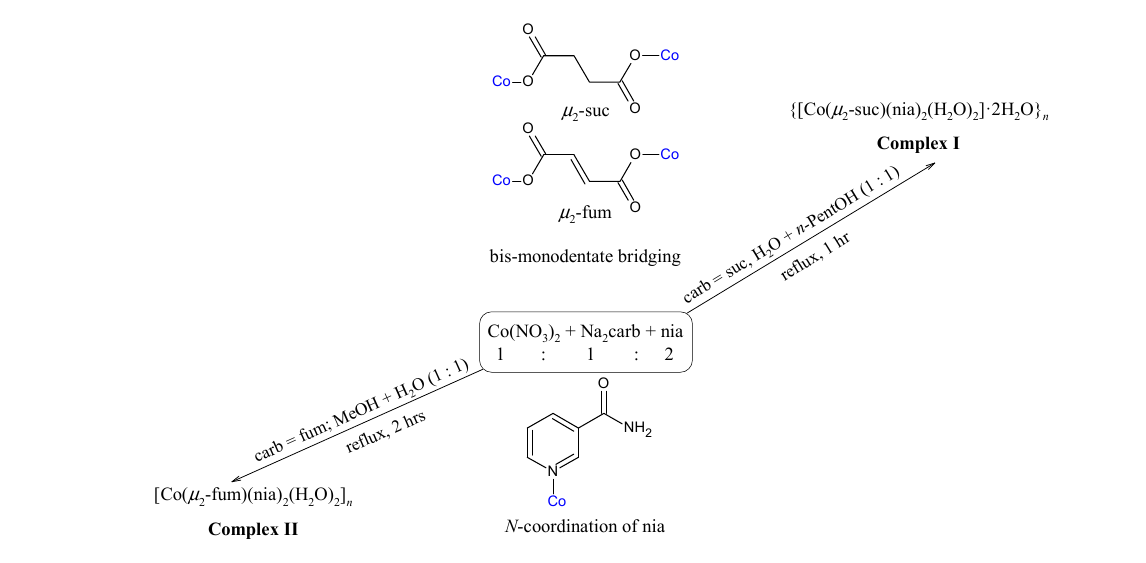
Scheme 1. Synthesis of polymeric cobalt(II)dicarboxylate complexes ( I and II ) from nicotinamide.